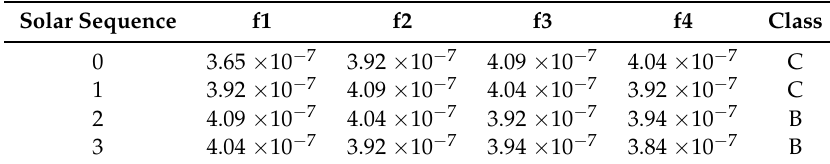
Table 4. Example of a “Solar Sequence Dataset (SSD)”.